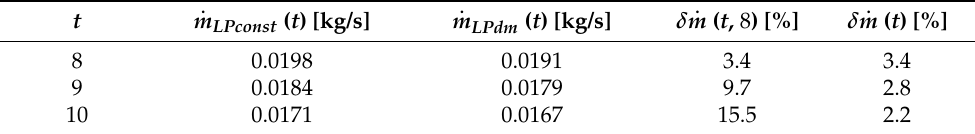
Figure 10. Distribution of air velocity in the seal of the initial geometry and of the designed one for the radial height RC = 0.315 mm comprising of ( a ) eight, ( b ) nine, and ( c ) ten teeth for boundary conditions 𝑝 𝑖𝑛 /𝑝 𝑜𝑢𝑡 = 2.4 , 𝑇 𝑖𝑛 = 300 K , 𝑝 𝑜𝑢𝑡 = 10 5 Pa . Table 3. Leakage rate for the seal of the initial geometry and of the designed one and their relative changes according to Equations (17) and (18), RC = 0.315 mm and of different number of teeth for 𝑝 𝑖𝑛 /𝑝 𝑜𝑢𝑡 = 2 , 𝑇 𝑖𝑛 = 300 K , 𝑝 𝑜𝑢𝑡 = 10 5 Pa .